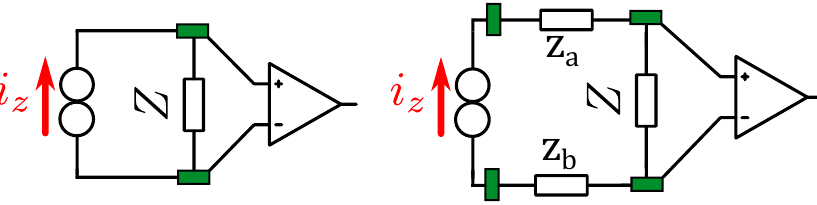
Figure 1. Brief schematic of a bipolar measurement setup ( left ) and a tetrapolar measurement setup ( right ): green rectangles indicate the electrodes placed. Z refers to the impedance under measure, while z a and z b refer to the bio-impedances between injection and measurement electrodes. The schematics are based on the description in [11], assuming infinite current source output impedance, infinite instrumentation amplifier input impedance, and negligible electrode